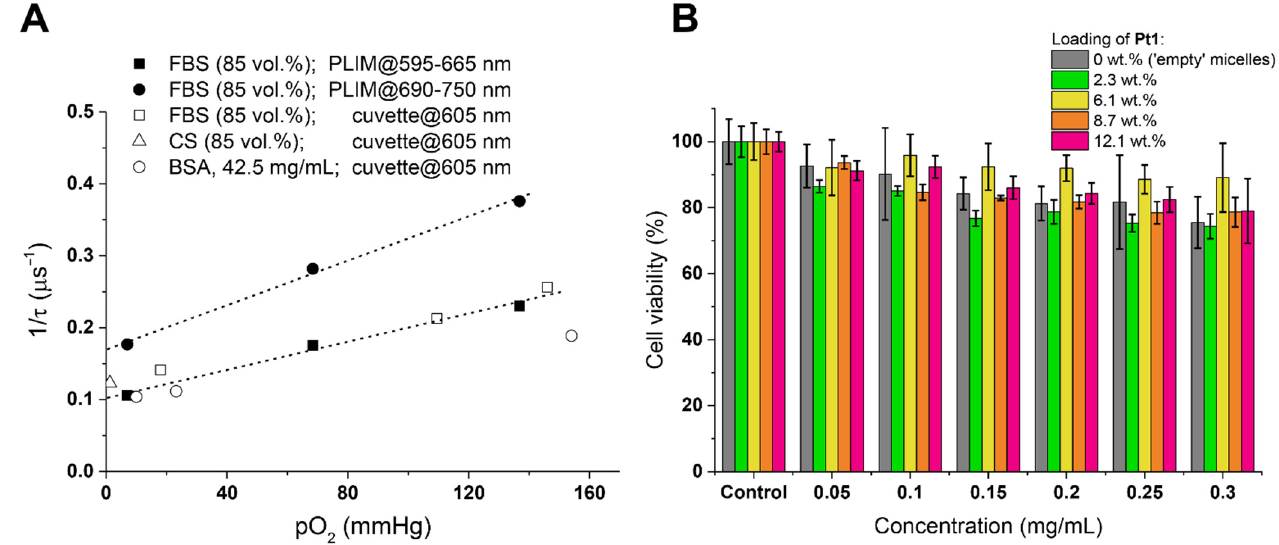
Figure 4. ( A ). Stern–Volmer plots of Pt1@PCL- b -PEG (12.1 wt.% of Pt1 ) in FBS (85 vol.%) measured by PLIM at 37 ° C. Excitation at 405 nm. Detection at 595–665 nm and 690–750 nm. Lifetimes meas- ured on lifetime measurement setup (excitation at 355 nm; detection at 605 nm) for FBS (85 vol.%), calf serum (85 vol.%), and BSA (42.5 mg/mL) at 37.7 ° C are presented as open symbols for